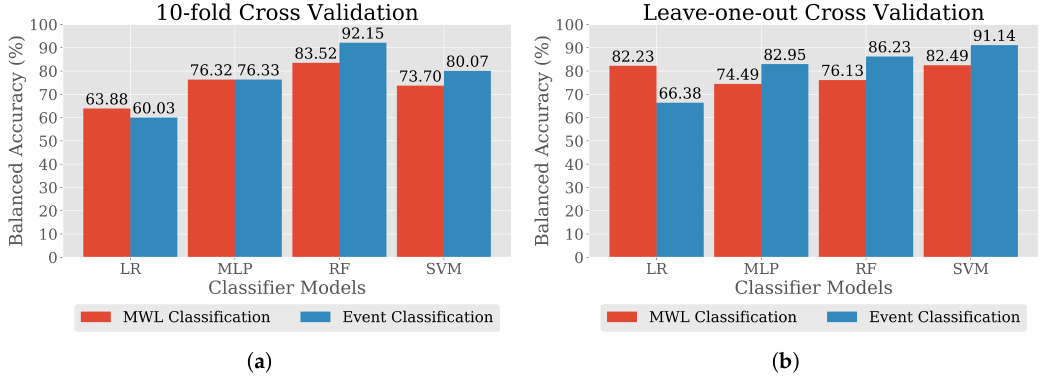
Figure 9. Maximum balanced accuracy in different CV method for MWL and event classification using MI-based features by different classifier models: ( a ) 10-fold CV and ( b ) Leave-One-Out (LOO)-subject CV. Table 8. Performance summary of classifying Car and Pedestrian events with LgR, MLP, SVM and RF classifier models using EEG and MI-based feature on the holdout test set among 738 observations where events due to pedestrian were considered as positive class. The number of observations with positive and negative class were 241 and 497 respectively. The highest accuracies obtained by using different feature sets are marked with ( * ). Using EEG-Based Features Using MI-Based Features Criteria LgR